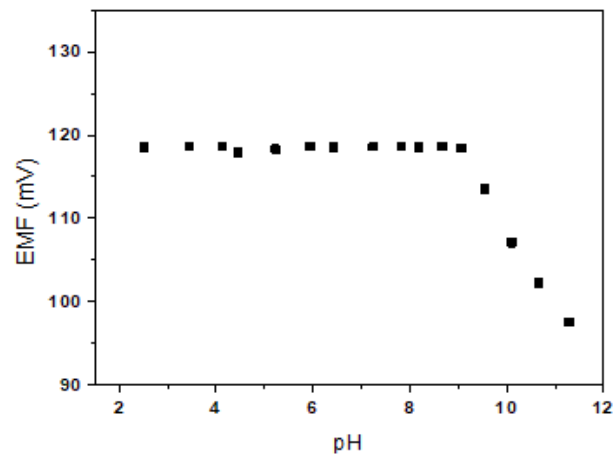
Figure 4. E ff ect of pH on E1 Figure 4. Effect of pH on E1 .